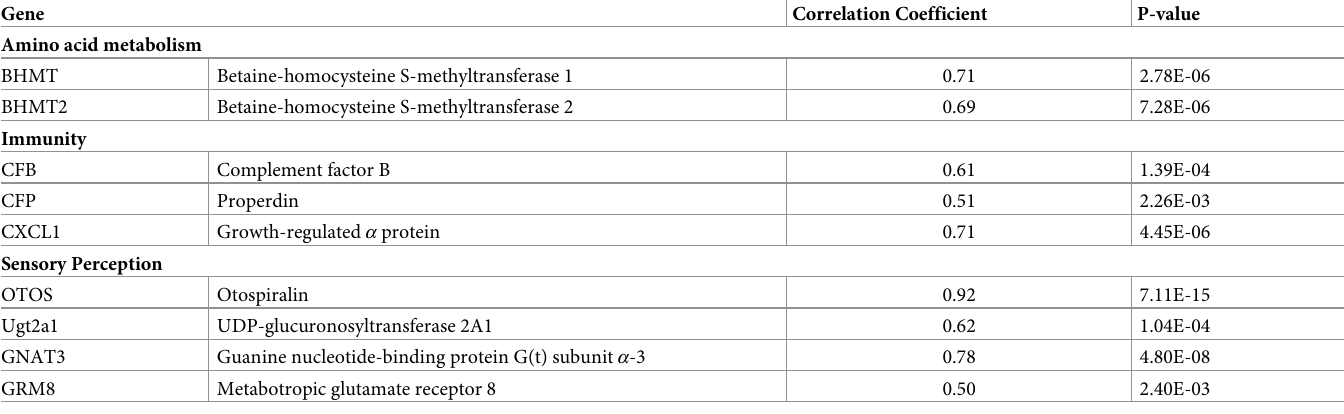
Coefficient correlation were obtained with a Pearson